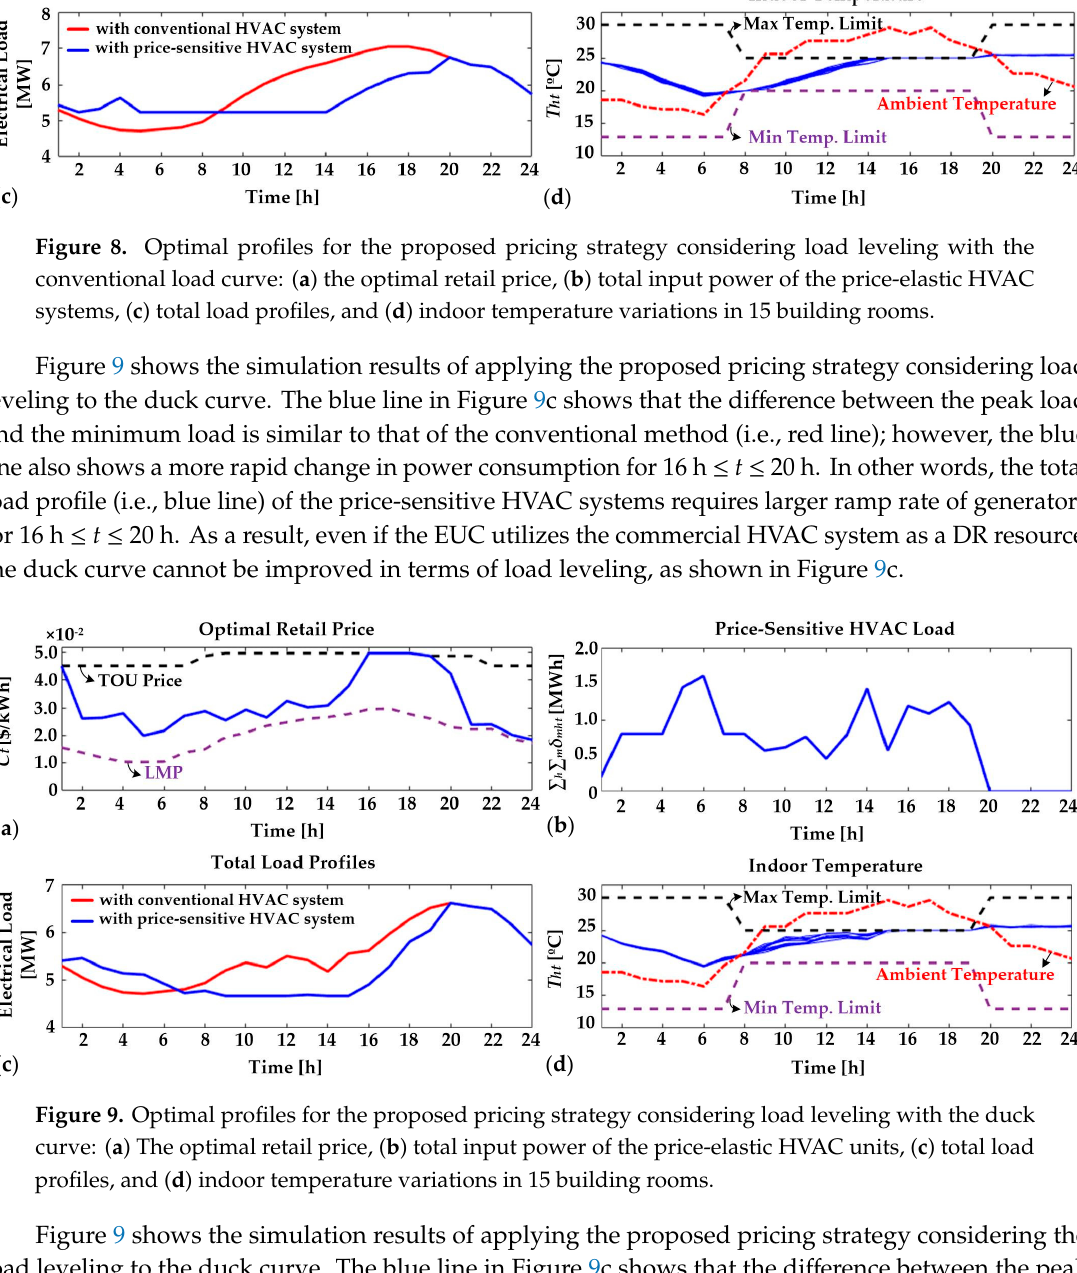
13 of 19 Figure 7. Optimal profiles for the proposed strategy considering peak load reduction with the duck curve: ( a ) the optimal retail price, ( b ) total input power of the price-elastic HVAC units, ( c ) total load profiles, and ( d ) indoor temperature variations in 15 building rooms. 4.3. Case Study B: Purpose of Demand Response We demonstrated that the proposed pricing strategy could be applied to other purpose such as load leveling besides peak load reduction. The simple constraint (i.e., P min < N HVAC · ∑ m δ mht + P R,t ) was added to (10) to show that price-sensitive HVAC systems can have positive effects even in terms of load leveling, and, the simulation results of applying the proposed pricing strategy to the conventional load curve are shown in Figure 8. To satisfy the added constraint, the EUC lowered C t for 6 h ≤ t ≤ 13 h to induce the power consumption of HVAC system. In particular, the blue line in Figure 8a had a minimum value at t = 6 h, and the EUC set C t close to the lower limit to increase power consumption during this time period. For HVAC system, the input power of the previous time